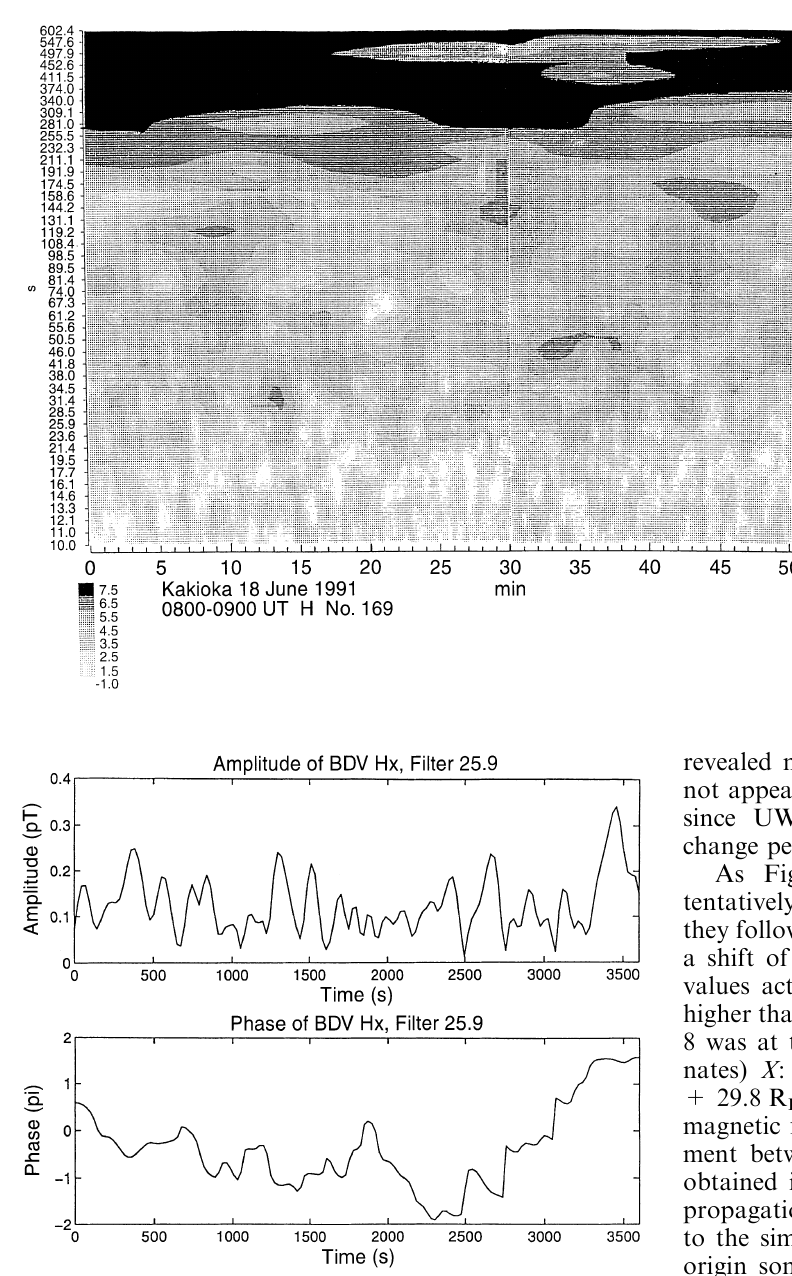
Fig. 4. Amplitude and phase of the 25.9-s filtered component at the station BDV with phase skips of (cid:112) at